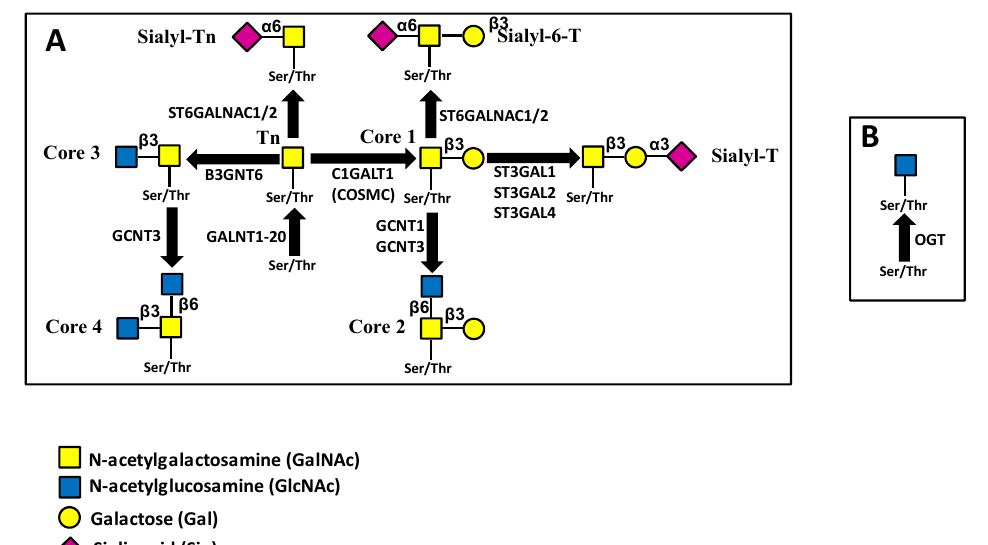
reactions but not mentioned in the text are not shown. Figure 3 . Pathways of O -glycosylation. ( A ) mucin-type; ( B ) O -GlcNAc. Enzymes catalyzing the